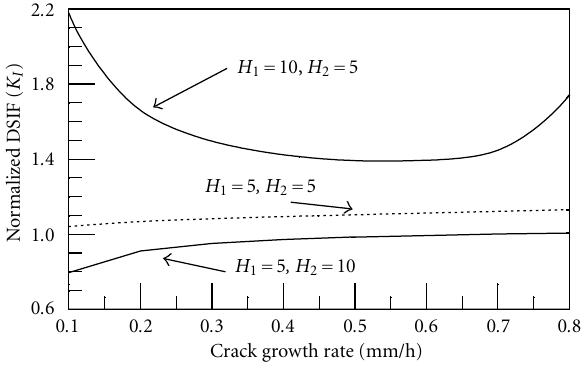
Figure 4.3. Variation of the normalized K I with the crack growth rate for di ff erent plate